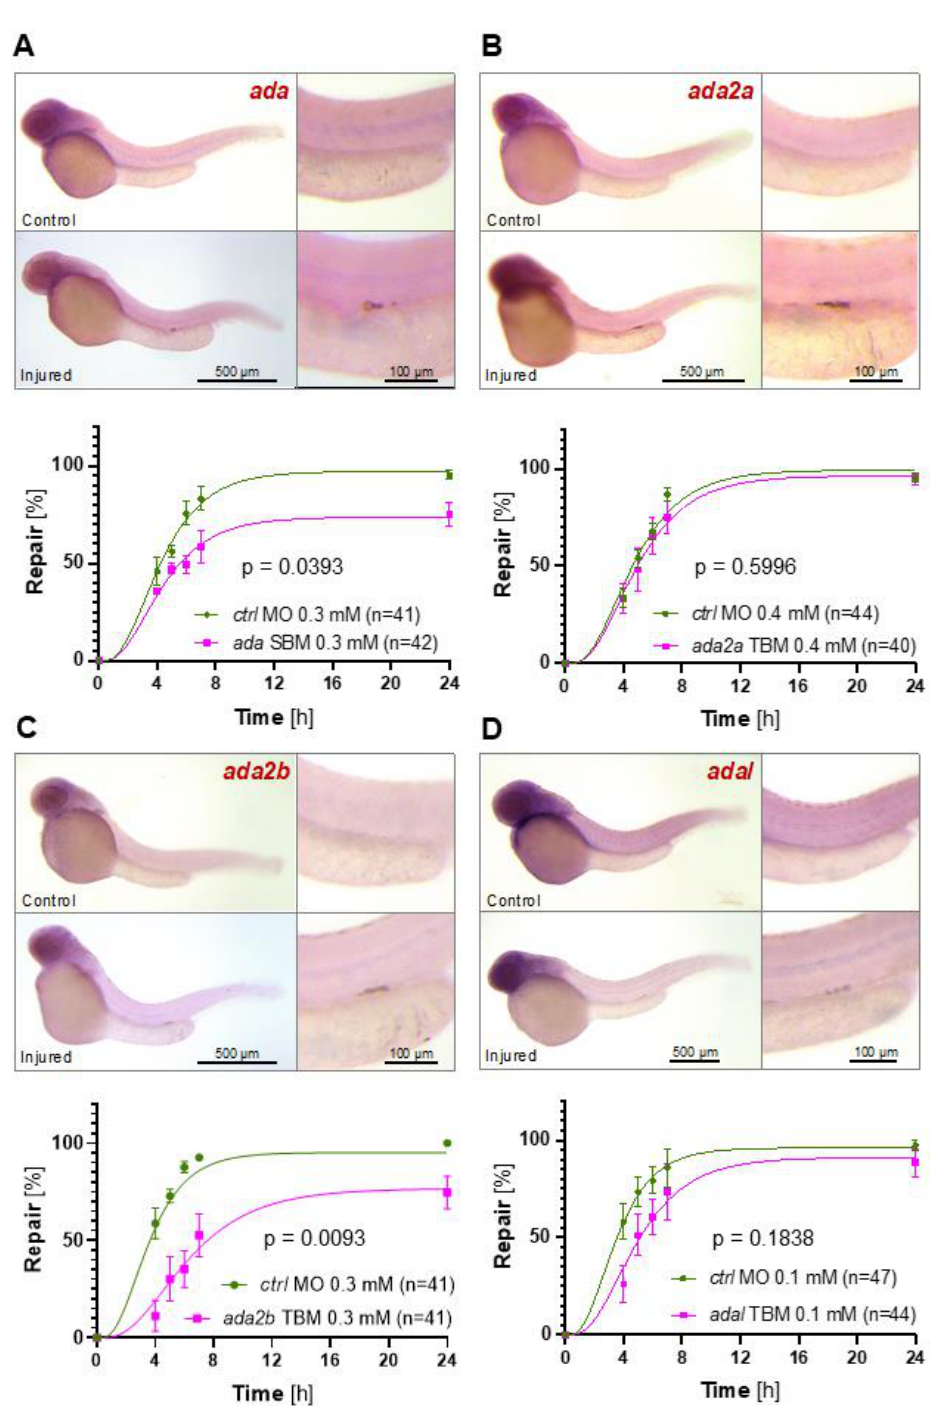
Figure 2. The involvement of adenosine deaminase family members in zebrafish pronephros repair. ( A ) In situ hybridization revealed upregulation of zebrafish ada. Depletion of zebrafish ada by a splice—(SBM) blocking morpholino oligonucleotides (MO) delayed the repair process. ( B ) In situ hybridization revealed upregulation of zebrafish ada2a. Depletion of zebrafish ada2a by a translation- (TBM) blocking morpholino oligonucleotides (MO) had no effect on the repair process. ( C ) In situ hybridization revealed upregulation of zebrafish ada2b. Depletion of zebrafish ada2b by a TBM delayed the repair process. ( D ) In situ hybridization revealed upregulation of zebrafish adal. Deple- tion of zebrafish adal by a TBM had no significant influence on the repair process (mean ± SEM; 2- way ANOVA).